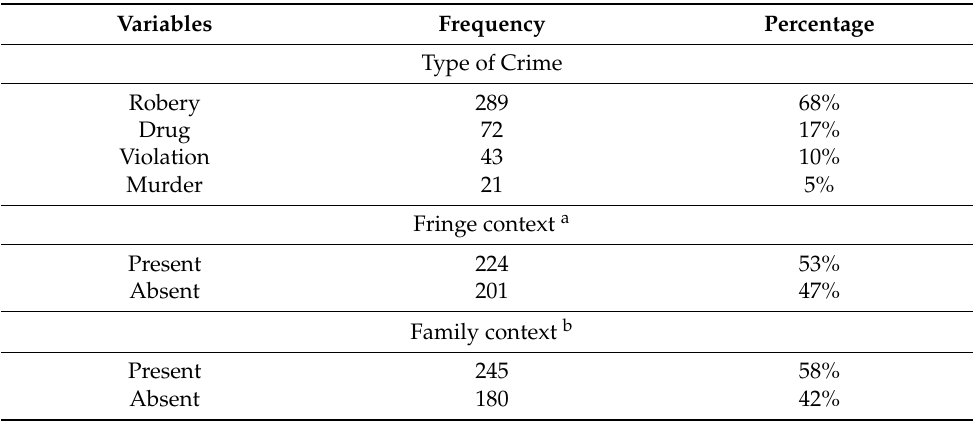
Table 3. Descriptive statistics for the type of crime and context (n =